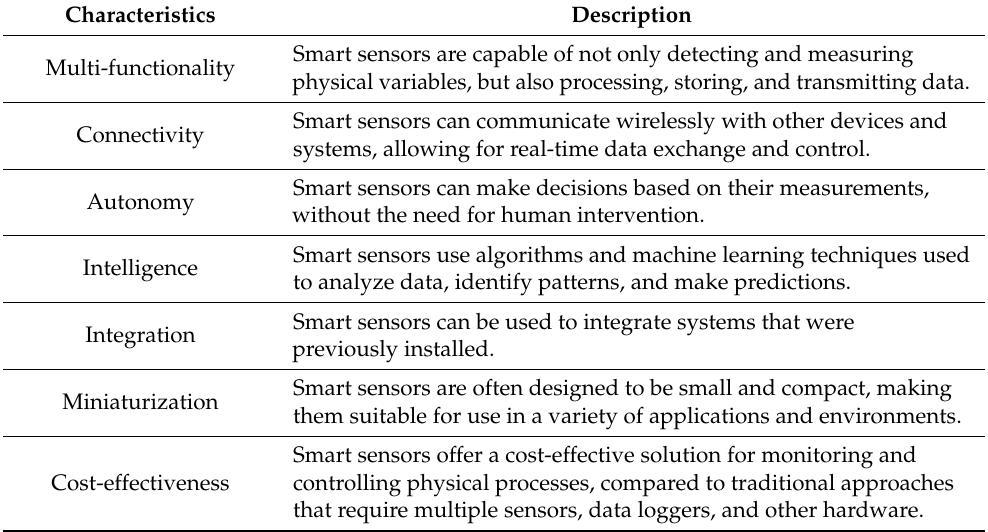
Table 1. Functions of a smart sensor.